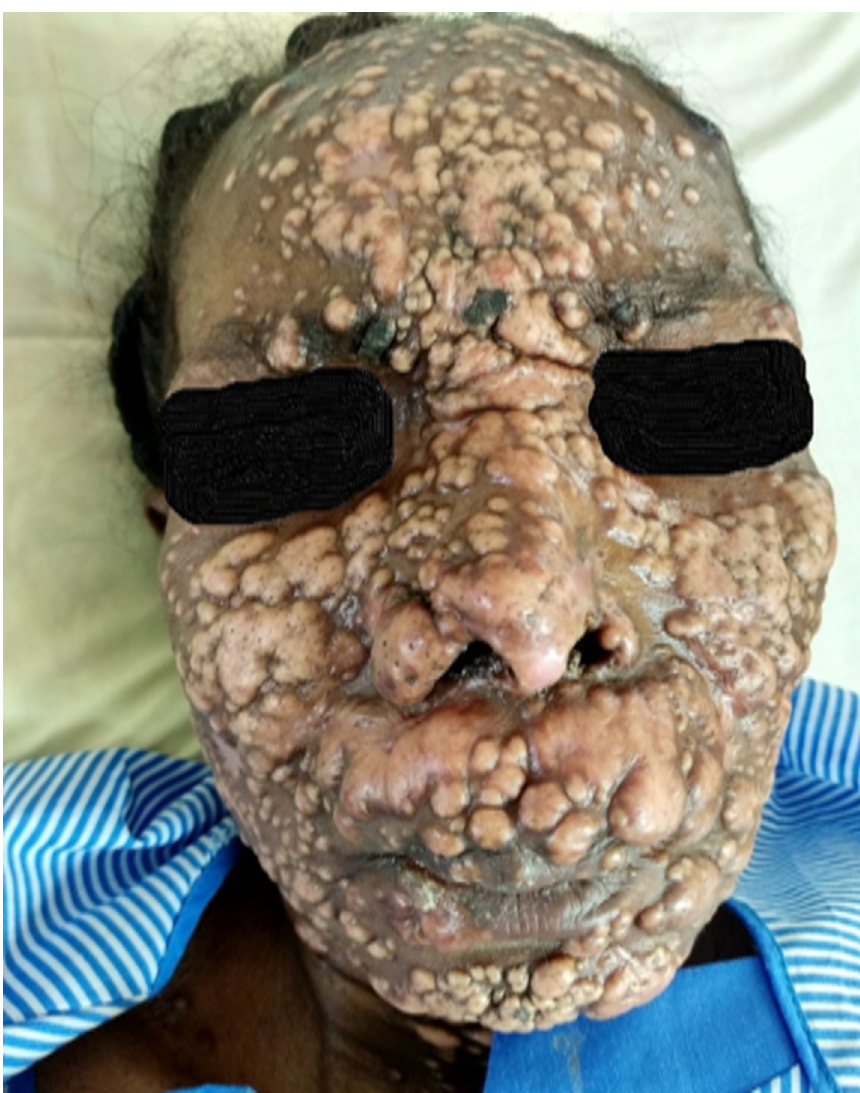
Fig 2. A AU : PleasecheckwhethertheeditsmadetoFig 2 captionarecorrect ; andamendifnecessary : 43-year-old HIV–positive female with variable sizes of fleshy hypopigmented papules and nodules with coalescing lesions especially on the nose, upper lips, and cheeks with secondary ulcers. Image courtesy : Dr . Martin Agyei